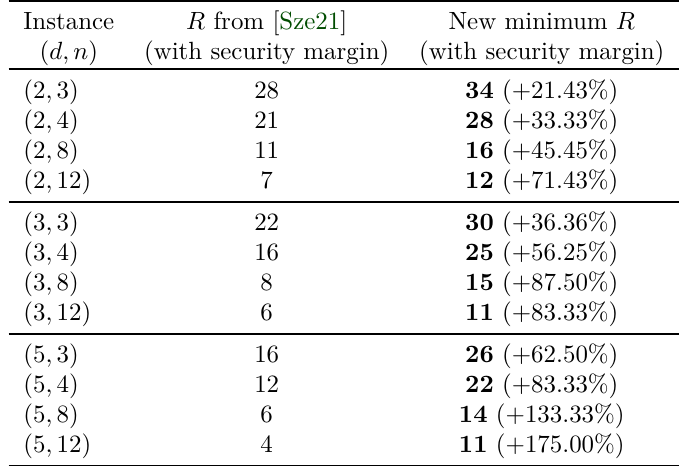
Table 4: Adjusted round numbers for Grendel for κ = 128 and p ≈ 2 256 considering our new attacks. We also list the recommended number of rounds from the original paper [Sze21], together with the incremental